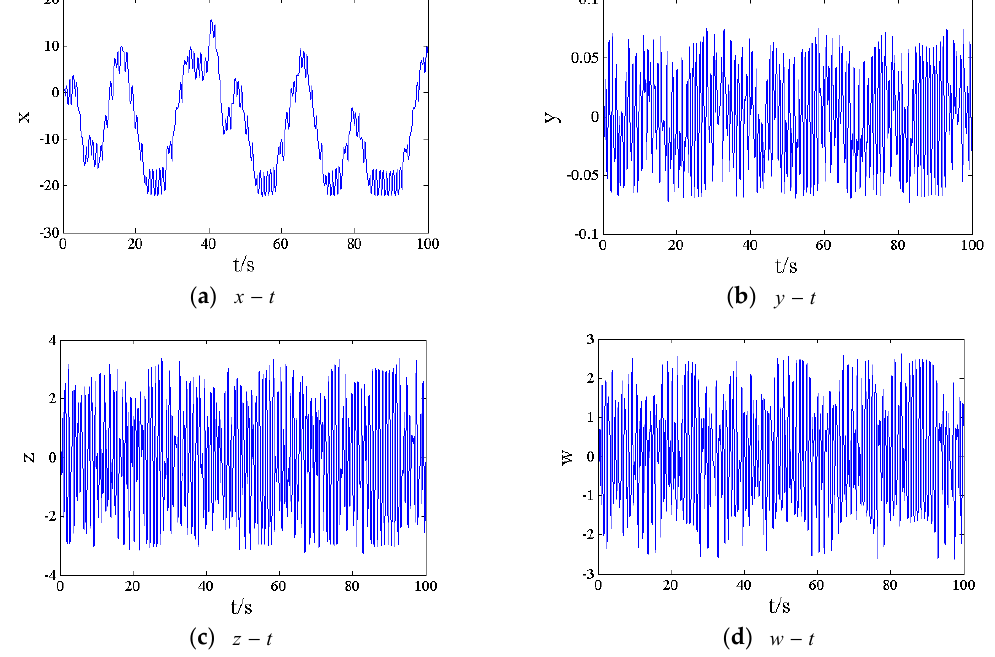
Figure 3. State time domain of hydro-turbine governing system (HGS) (18). ( a ) x − t ; ( b ) y − t ; ( c ) z − t ; ( d ) w − t